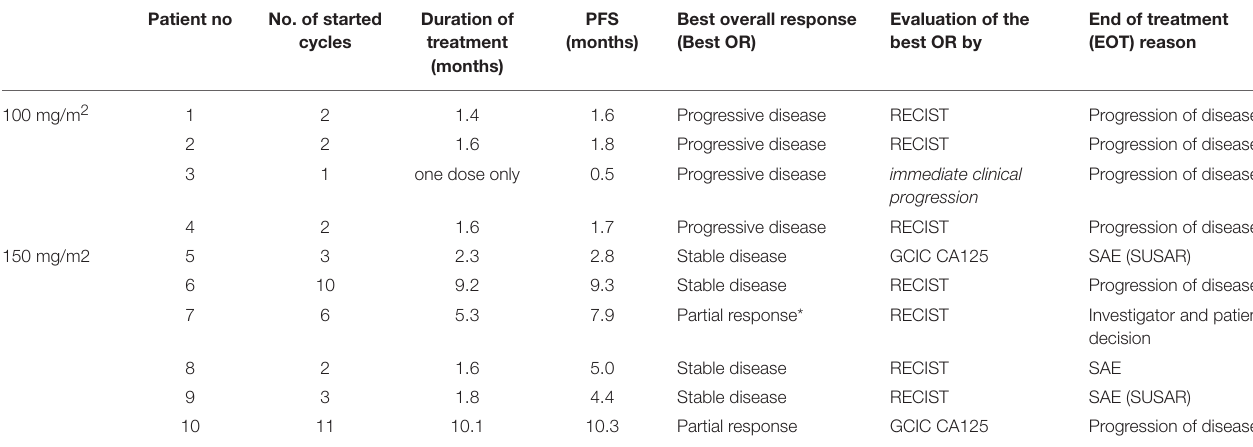
TABLE 5 | Treatment exposure and clinical activity.